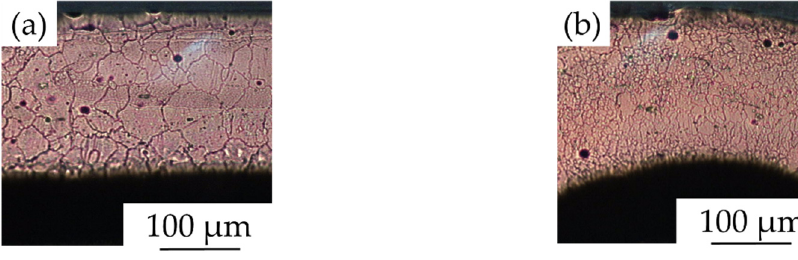
Figure 27. Microstructure of the wrinkled tube obtained from the cylinder-shape warm THF in Stage (2) at 250 °C: ( a ) microstructure in the non-deformed area; ( b ) microstructure at the top of the wrinkle.